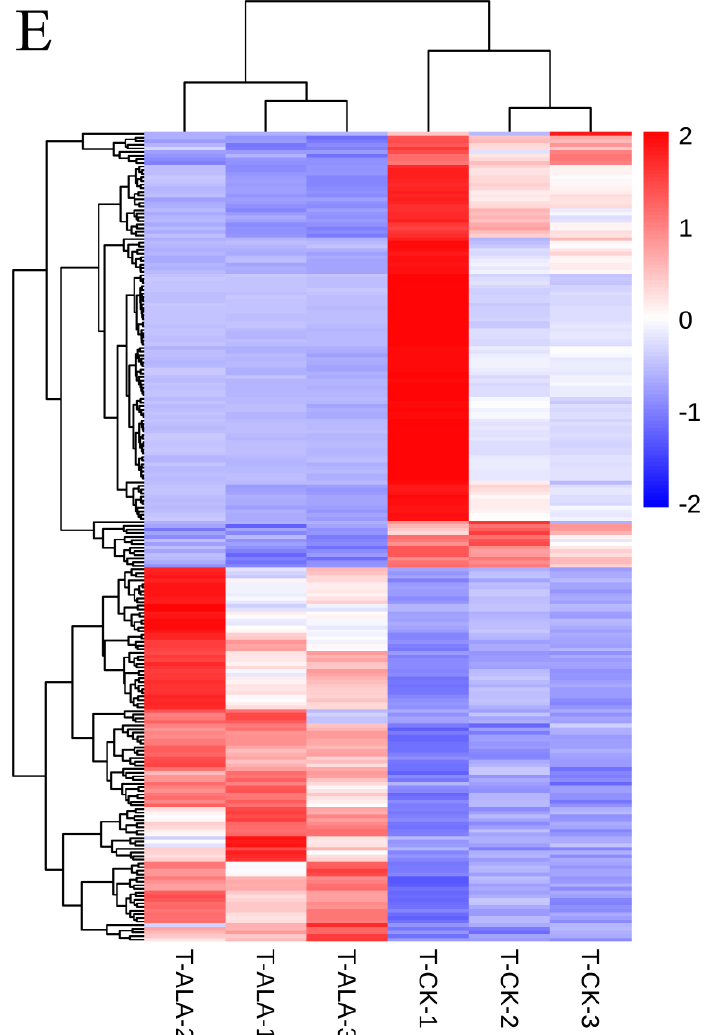
Figure 3. The expression patterns and functional clustering of all DEGs involved in the T-A vs. T-CK comparison. ( A , C ) Gene ontology enrichment analysis illustrated the distribution of gene function on up-regulated and down-regulated DEGs in T-A vs. T-CK comparison. ( B , D ) KEGG pathway enrichment analysis on up-regulated and down-regulated DEGs in T-A compared to T-CK. ( E ) The heatmap showed the expression of all DEGs in the comparison of T-A vs. T-CK.